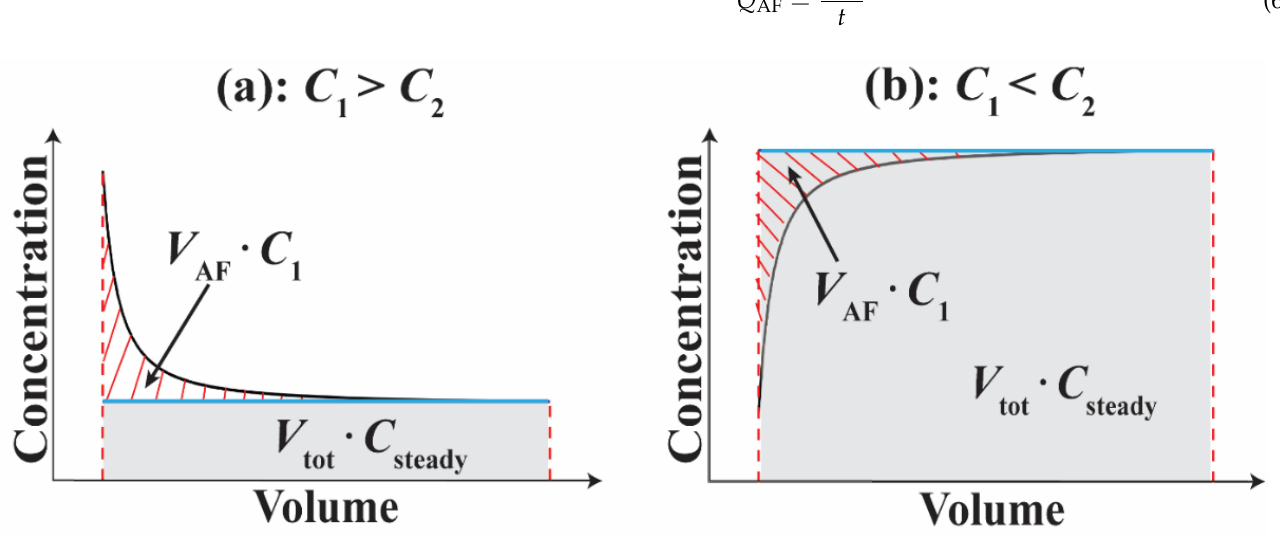
Figure 4. Specific scenarios generating changes in the concentration of a conservative tracer during pumping: ( a ) C 1 > C 2 and ( b ) C 1 < C 2 . In each panel, the black curve indicates the observed concentration during the pumping. The blue line indicates the concentration under the steady state.